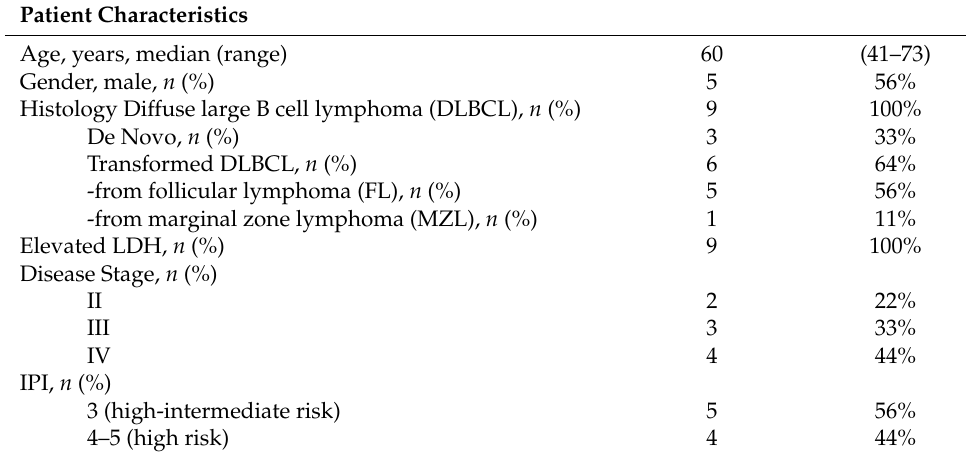
Table 1. Patient characteristics at